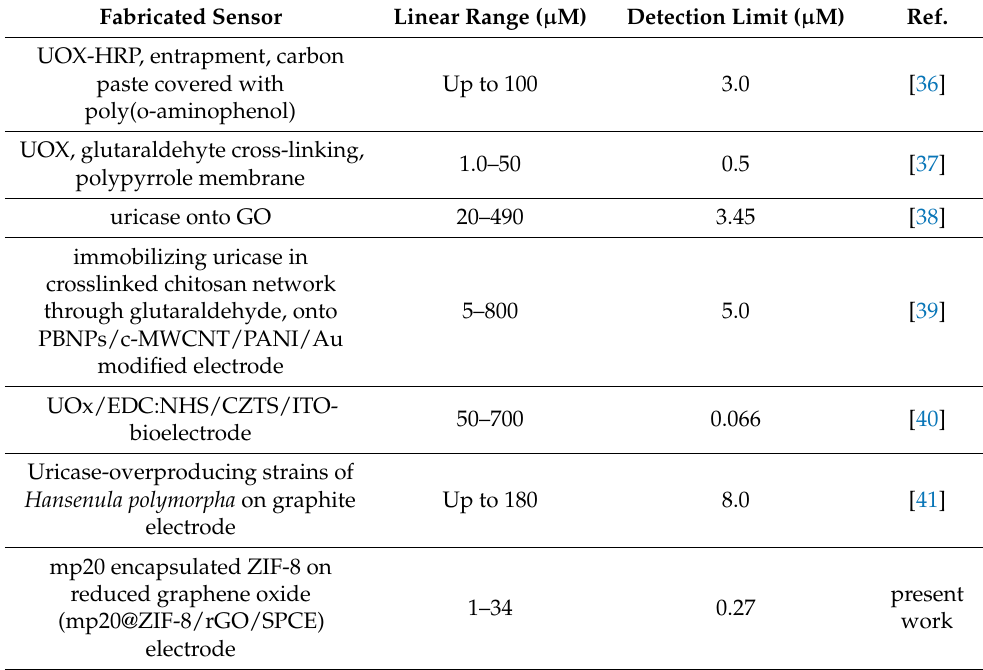
Table 3. A comparison of different electrochemical biosensors for the detection of uric acid.